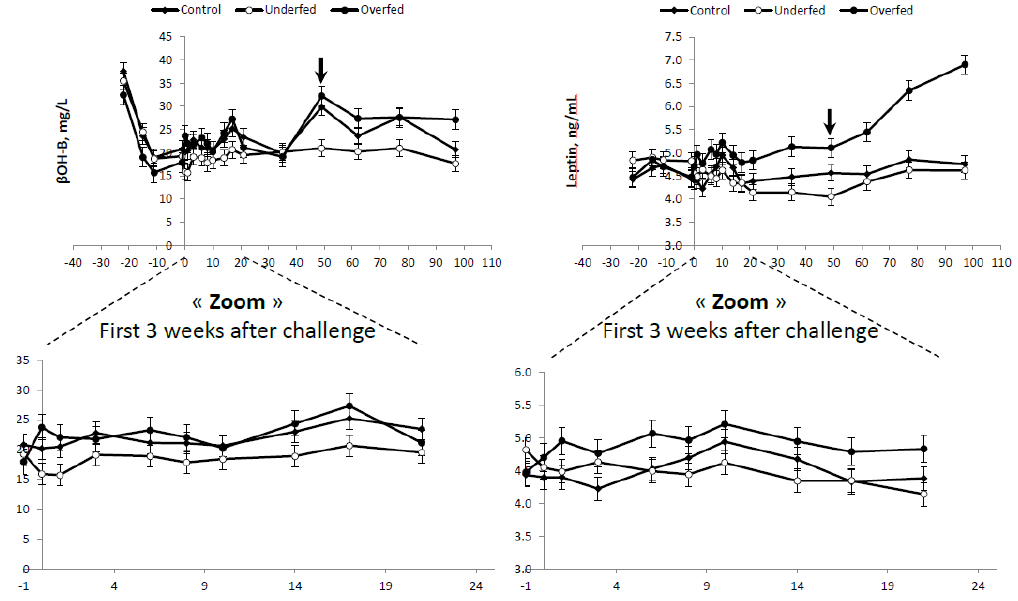
Figure 4. Energy metabolism (β-hydroxybutyrate—β-OHB—and leptin) plasma profile of mature, dry, nonpregnant Merinos d’Arles ewes ( n = 36) offered different diets during the dry-off period, i.e., 70% (underfed; n = 12), 100% (control; n = 12) or 160% (overfed; n = 12) of the maintenance energy requirements. Diet challenge started at day 0, after a 3-week adaptation period. Arrow represents commencement of the refeeding period. Bars are